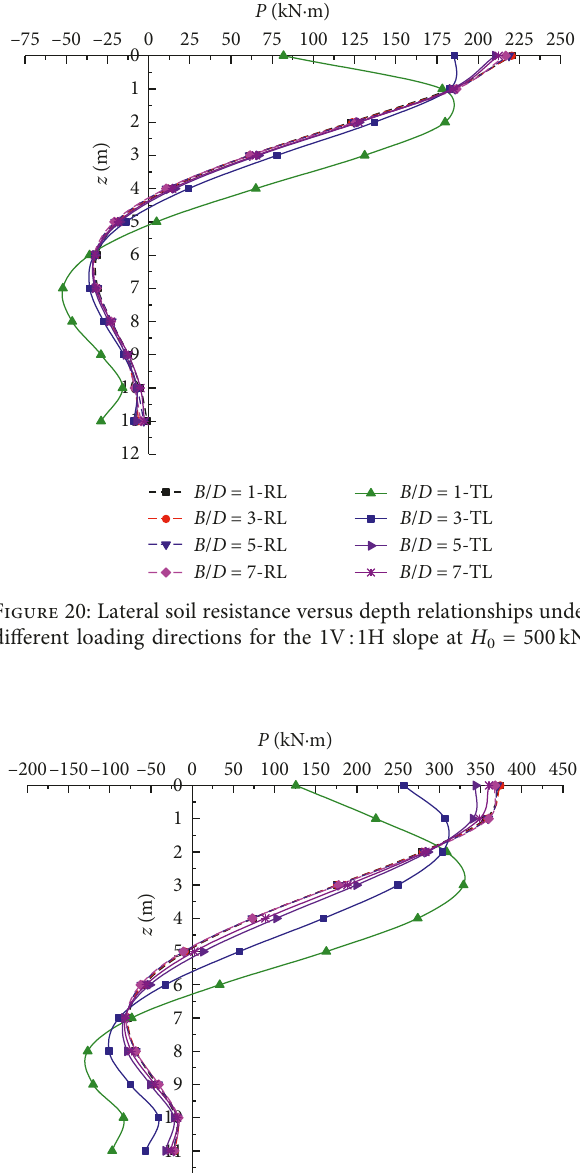
Figure 21: Lateral soil resistance versus depth relationships under different loading directions for the 1V:1H slope at H 0